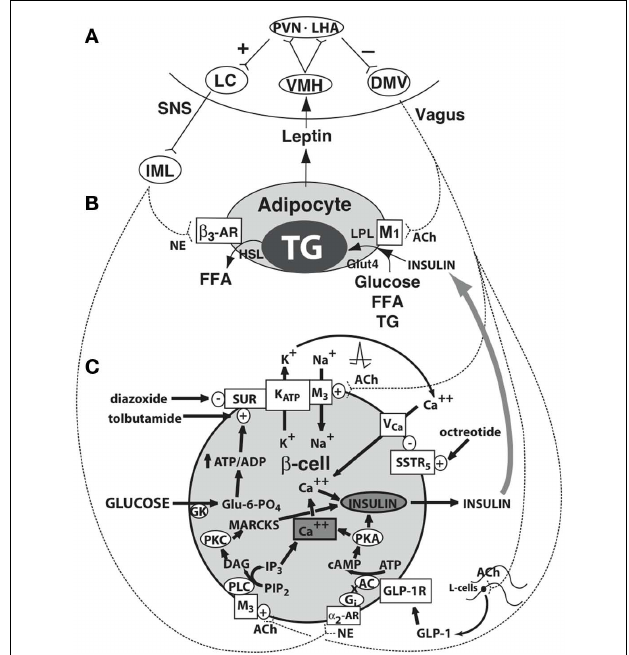
FIGURE 2 | Central regulation of leptin signaling, autonomic innervation of the adipocyte and β -cell, and the starvation response. (A) The arcuate nucleus transduces the peripheral leptin signal as one of sufficiency or deficiency. In leptin sufficiency, efferents from the hypothalamus synapse in the locus coeruleus, which stimulates the sympathetic nervous system. In leptin deficiency, efferents from the hypothalamus stimulate the dorsal motor nucleus of the vagus. (B) Autonomic innervation and hormonal stimulation of white adipose tissue. In leptin sufficiency, norepinephrine binds to the β 3 -adrenergic receptor, which stimulates hormone-sensitive lipase, promoting lipolysis of stored triglyceride into free fatty acids. In leptin deficiency, vagal acetylcholine increases adipose tissue insulin sensitivity (documented only in rats to date), promotes uptake of glucose and free fatty acids for lipogenesis, and promotes triglyceride uptake through activation of lipoprotein lipase. (C)